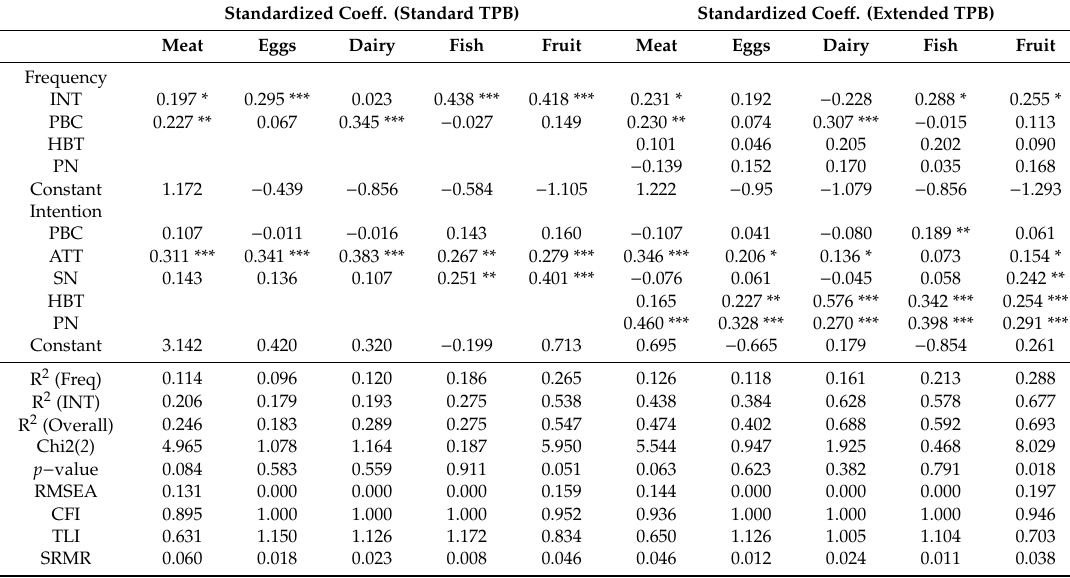
Table 5. Structural equation modeling (SEM) analysis results of standard and extended TPB models for frequency and intention of consuming meat, eggs, dairy, fish, and